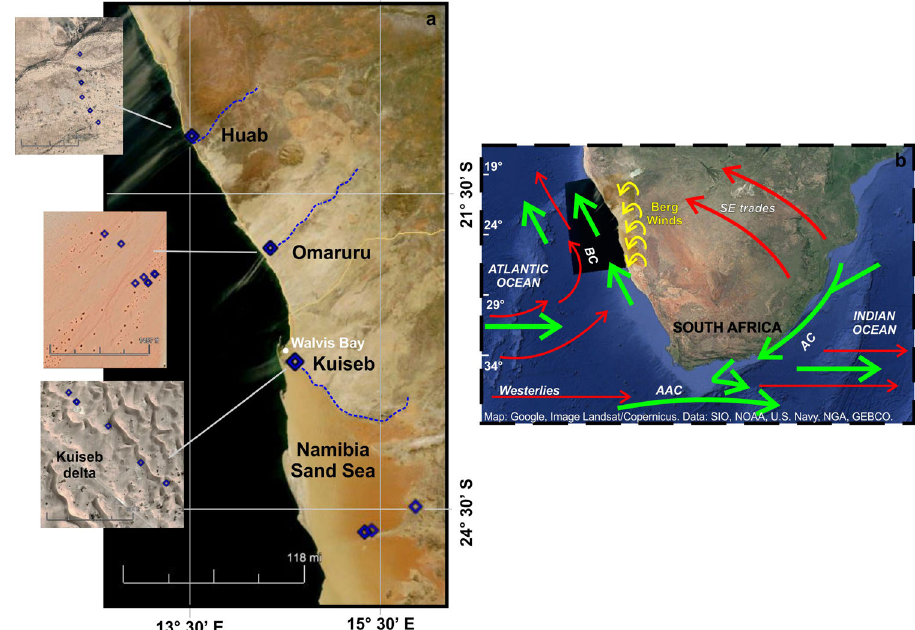
Fig. 1 Geographical and climatological characterization of Southern Africa Potential dust source areas. a satellite image of dust plumes originated off the coast of Namibia captured in May 2013 by The Moderate Resolution Imaging Spectroradiometer (MODIS) on NASA ’ s Terra satellite showing the study areas of Huab, Omaruru, Kuiseb and the Nambia Sea Sand. The hydrographic Huab, Omaruru and Kuiseb systems are indicated by the blue lines. b map of southwestern Africa showing the major features of the regional climate system. Main oceanic currents are indicated in bold green arrows and atmospheric circulations in red (south easterly trade and westerlies winds) and yellow (Berg winds). BC: Benguela Current; ACC: Antarctic Circumpolar Current; AC: Aghulas Current. The map in Fig. b was built using Google Earth Pro, Image Landsat/Copernicus; Data: SIO, NOAA, U.S Navy, NGA, GEBCO,